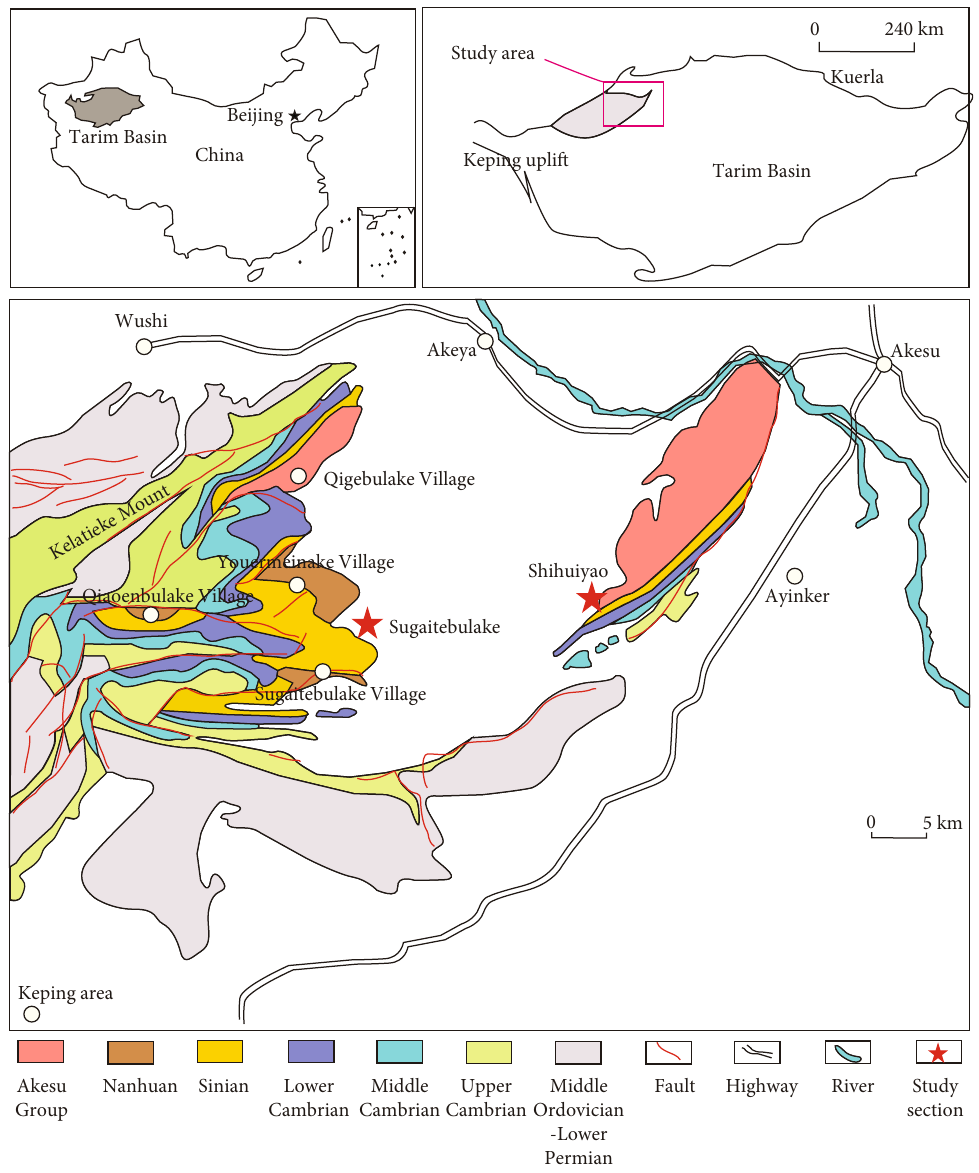
Figure 1: Location of study area and sampling